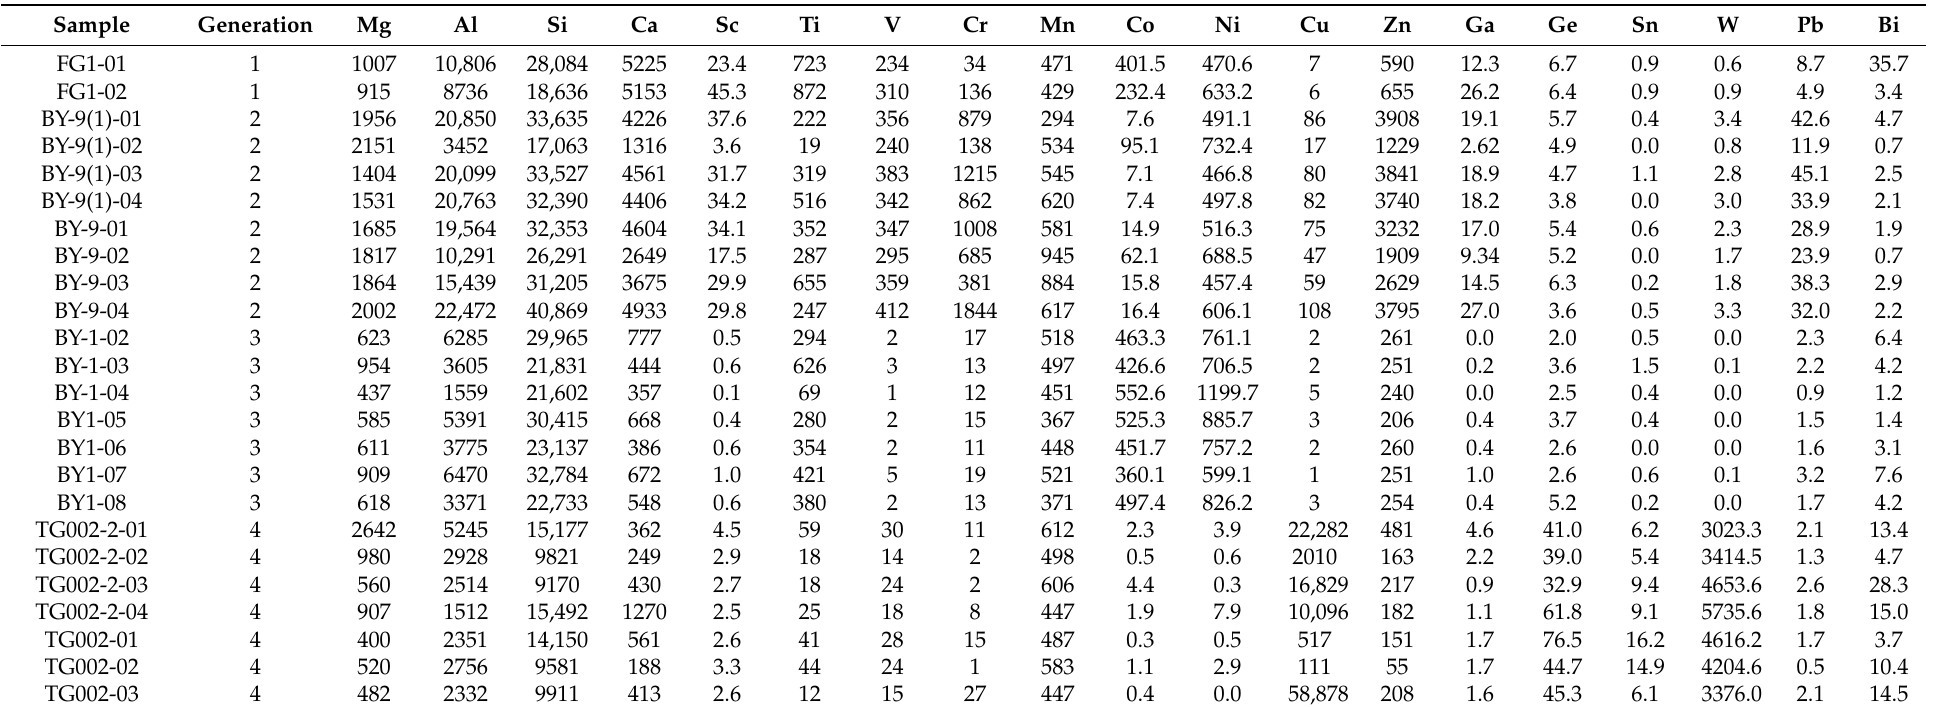
Table 2. LA-ICP-MS trace element data (ppm) of magnetite from Tonggou